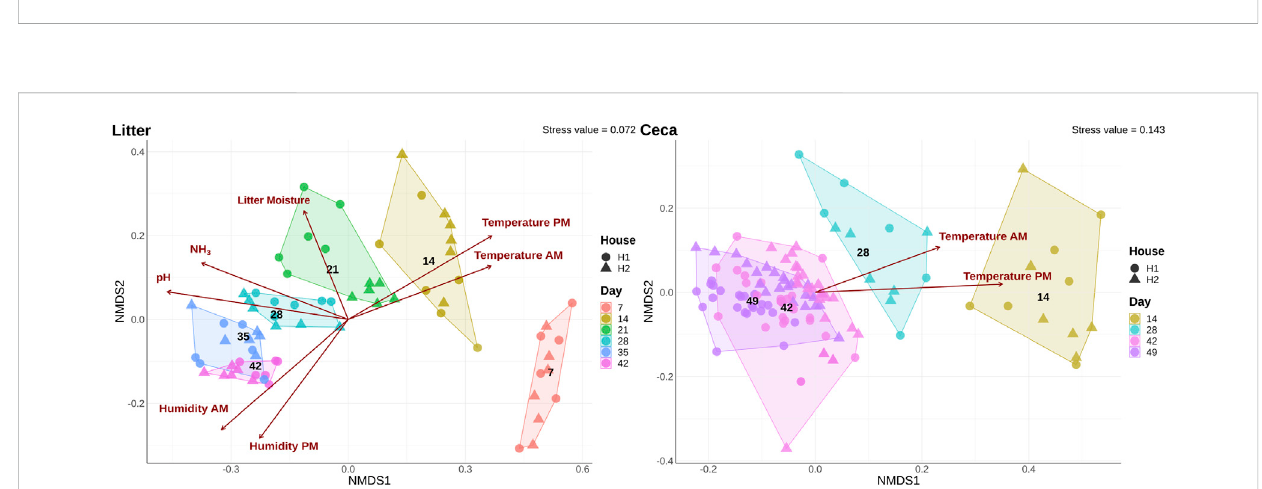
Changeofalphadiversityindicesfromrare fi ed16SrRNAgenelibrariesovertime.Boxesindicatetheinterquartilerange(75thto25th)ofthedata.The medianvalueisshownasalinewithinthebox.Whiskersextendtothemostextremevaluewithin1.5*interquartilerangeanddotsrepresentoutliers.Only signi fi cant changes are shown with asterisks: *: p ≤ 0.05, **: p ≤ 0.01, ***: p ≤ 0.001. The color of asterisks shows pairwise comparisons between ceca (orange) or litter (green) samples.